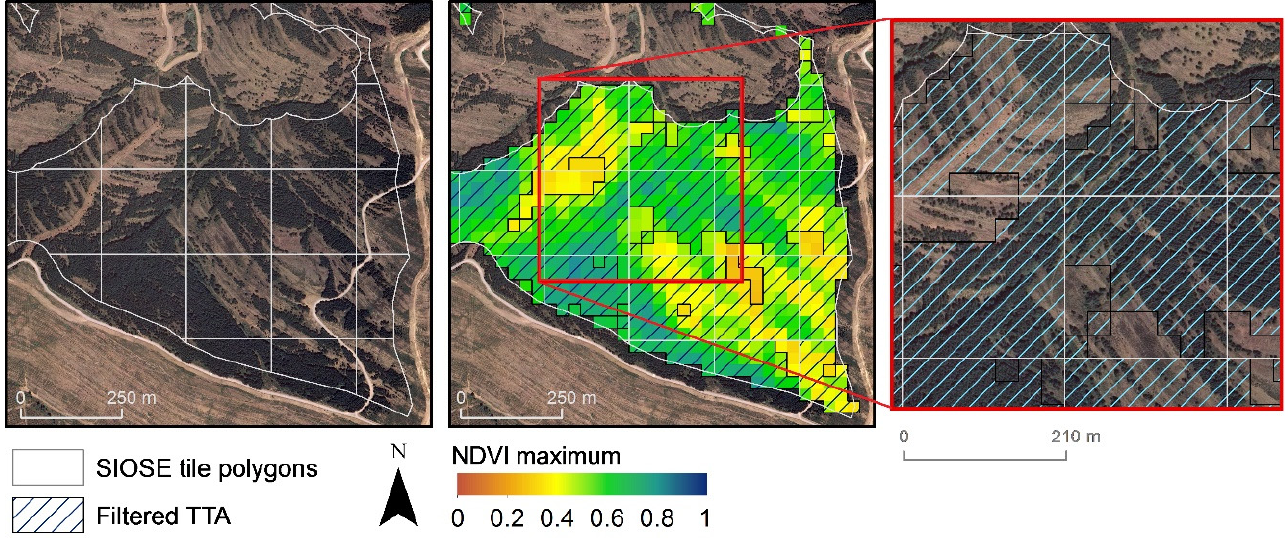
Figure 10. Rule 1 filtering applied over a polygon association.